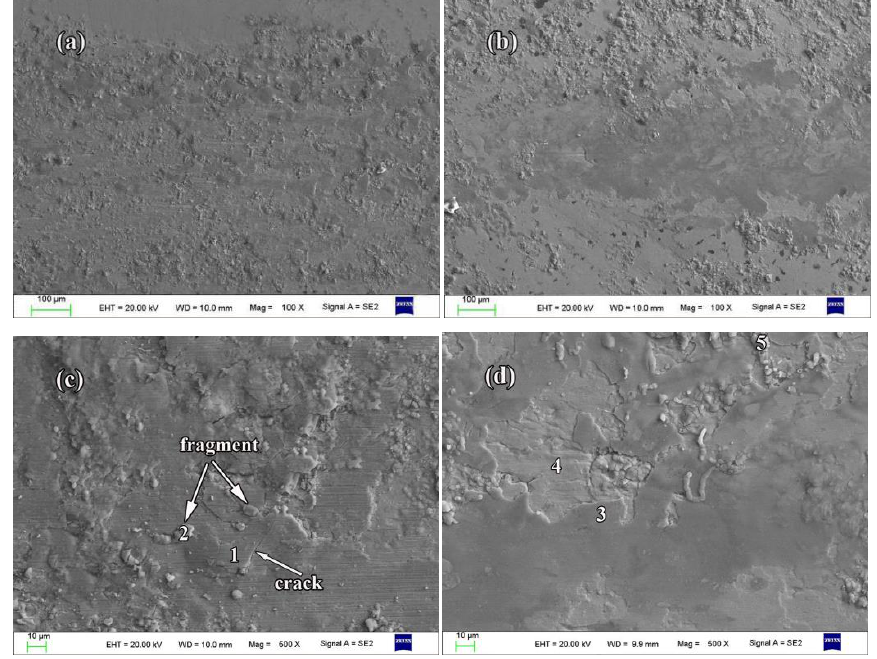
Figure 10. SEM micrographs of the worn surfaces of the ( a , c ) the top of the gradient remelted layer (M1) and the ( b , d ) the position where the hardness was two-thirds of the top of the remelting layer (M2). Table 1. Results of EDS analysis at different positions according to Figure 10c,d.